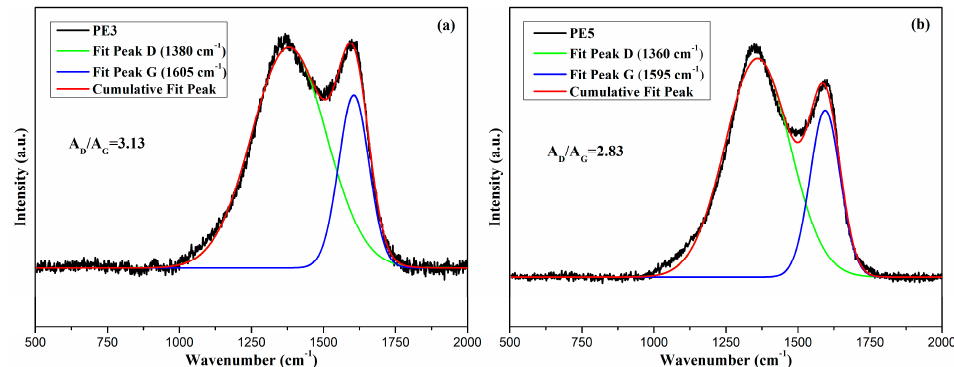
Figure 12. Raman spectra of char residues for PE3 ( a ) and PE5 ( b ) after CCT.